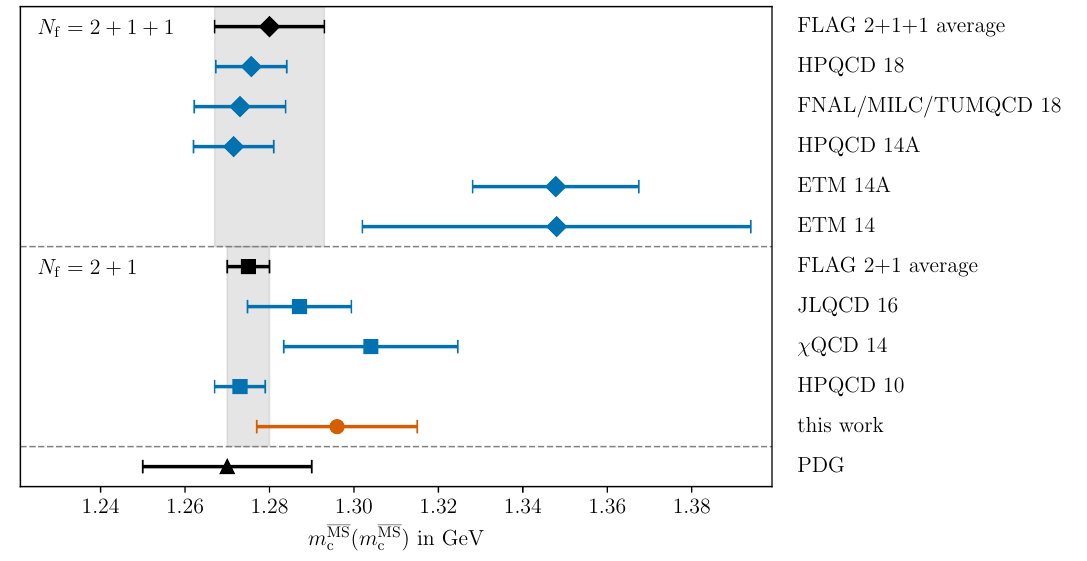
( m MS ) in the four-flavour theory with c c = 2 + 1 + 1 and N = 2 + 1 f f